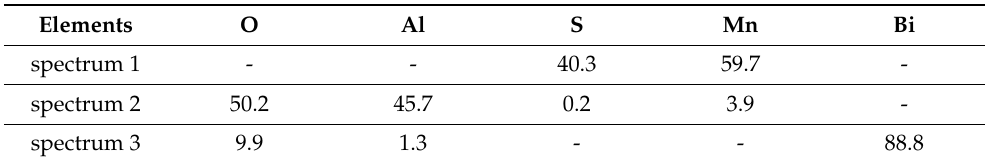
Table 5. Local chemical composition [in wt. %] of individual parts of non-metallic inclusions, steel with 0.12 wt. % Bi [wt. %].